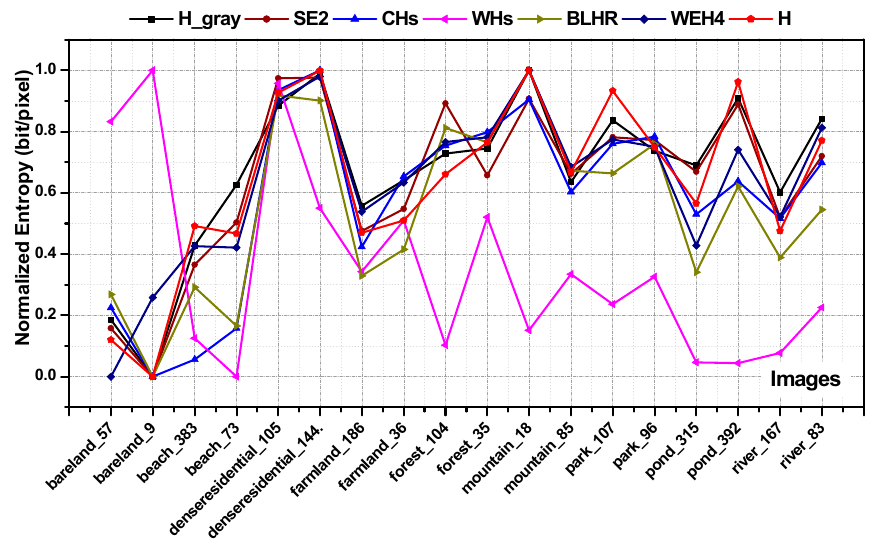
Figure 8. Normalization values of the information content measured by different entropy models.